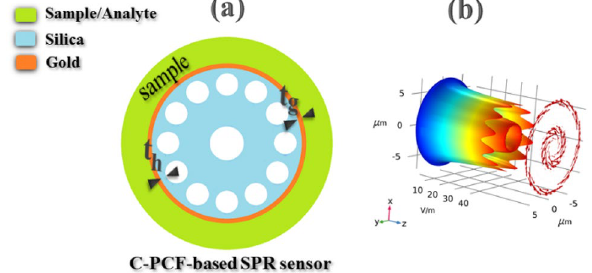
Figure 1. ( a ) The cross-sectional view of the proposed C-PCF-based SPR sensor; and ( b ) the intensity profile indicating strong coupling between the TE 01 and the SPP modes. The background material is made of silica (blue region), the white circles are air holes, the red ring is gold coated on the fiber cladding with a thickness of t g and distance of t h to the air holes, and the green region is the sample